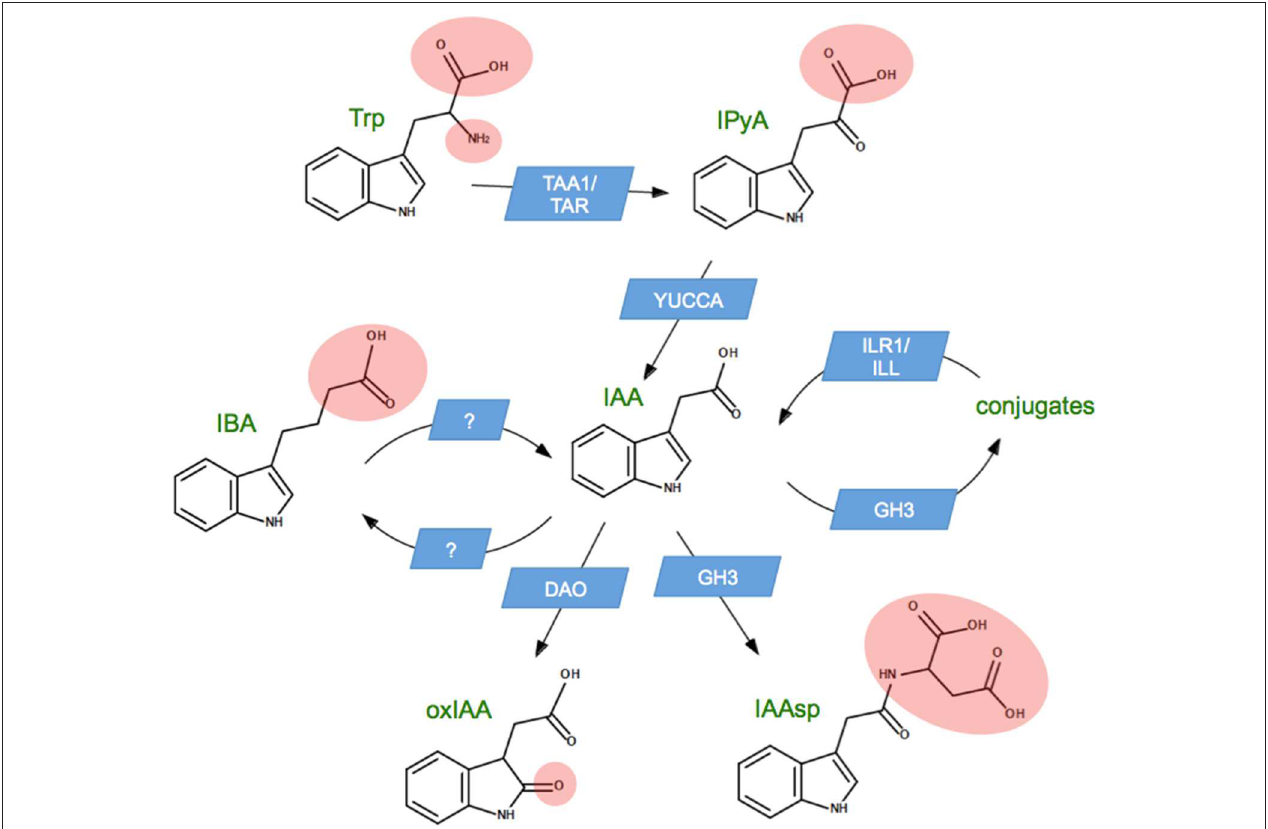
is irreversible, so this constitutes a second catabolic pathway. The figure also shows reversible conversion to indole-3-butyric acid (IBA), an auxin-like compound with a role in adventitious root formation. Blue boxes indicate the name of the gene family responsible for each pathway. Pink ellipses are added for clarity, to indicate the portion of each chemical structure that differs from